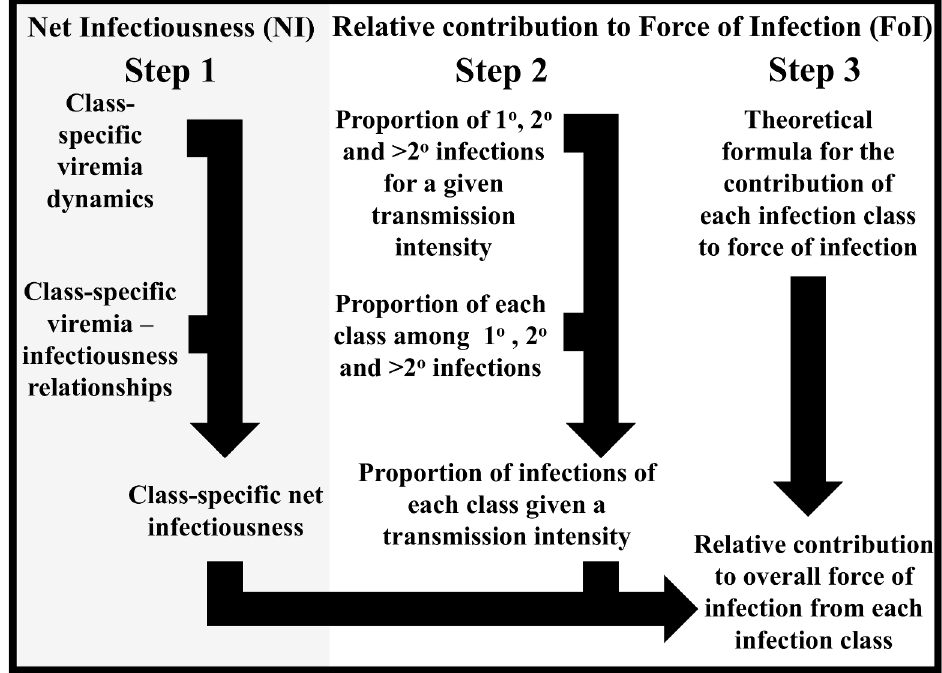
Fig 1. Flowchart of methodological framework. Our overall approach consisted of three steps, depicted in the three columns. The products of all three combine to yield our estimate of the relative contribution to overall force of infection from each infection class. Likewise, uncertainty in each component of the analysis is propagated into other components of the analysis through repeated Monte Carlo sampling, with Monte Carlo samples from one portion of the analysis flowing to others according to the arrows and providing the basis for credible intervals reported in the Results section. Details of how the sub-steps indicated in this figure were performed are described in subsections of the Materials and Methods